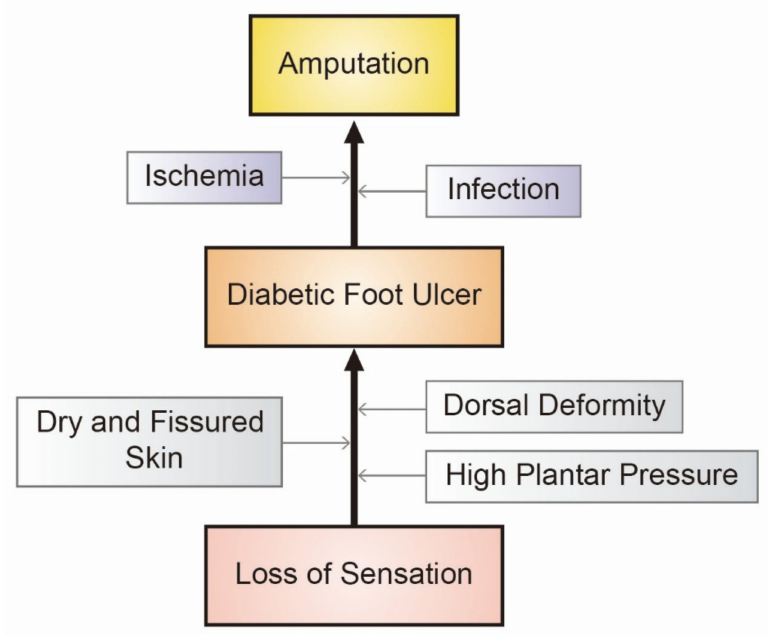
Figure 2. Major causal factors that lead to lower extremity amputation in